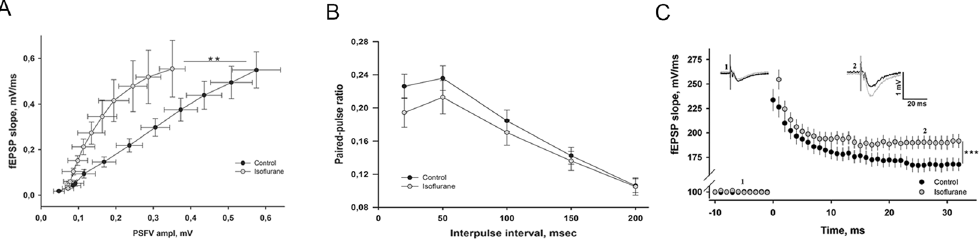
Figure 7. Isoflurane accentuates glutamatergic transmission and plasticity in the hippocampus. ( A ) Slope of field excitatory postsynaptic potential (fEPSP) recorded in the area CA1 plotted as a function of presynaptic fiber volley (PSFV) amplitude recorded in slices from mice treated with isoflurane (30 min) at 24 hours before (n = 12 slices/8 mice) and in control animals (n = 10 slices/7 mice) (one-way ANOVA: F 1,20 = 1.314, p = 0.0479). ( B ) Paired-pulse facilitation induced by two consecutive stimuli with interpulse interval (IPI) between 10 and 200 msec was not different between the groups (F 1,10 = 0.354, p = 0.564). n = 9 slices/8 mice for isoflurane group and n = 10 slices/7 mice for control group. Statistical analysis was done using one-way ANOVA. ( C ) Long-term potentiation (LTP) induced by high-frequency stimulation (HFS, 100 Hz/1 s) is significantly enhanced in slices from isoflurane treated animals (two-way ANOVA: F 1,64 = 7.91, p = 0.000896; n = 8 slices/8 mice for isoflurane group and n = 8 slices/7 mice for control group). Representative fEPSPs taken before and 30 min after the HFS are shown in the insets (control = black, isoflurane =